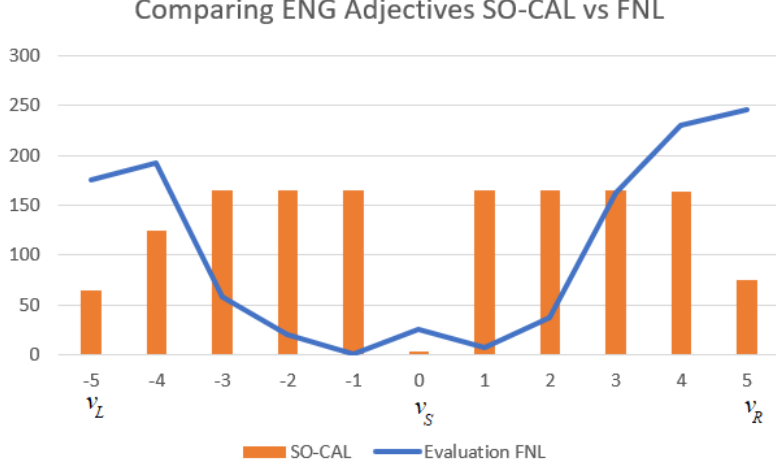
Figure 7. English Adjectives SO-CAL vs. FNL lexicon.